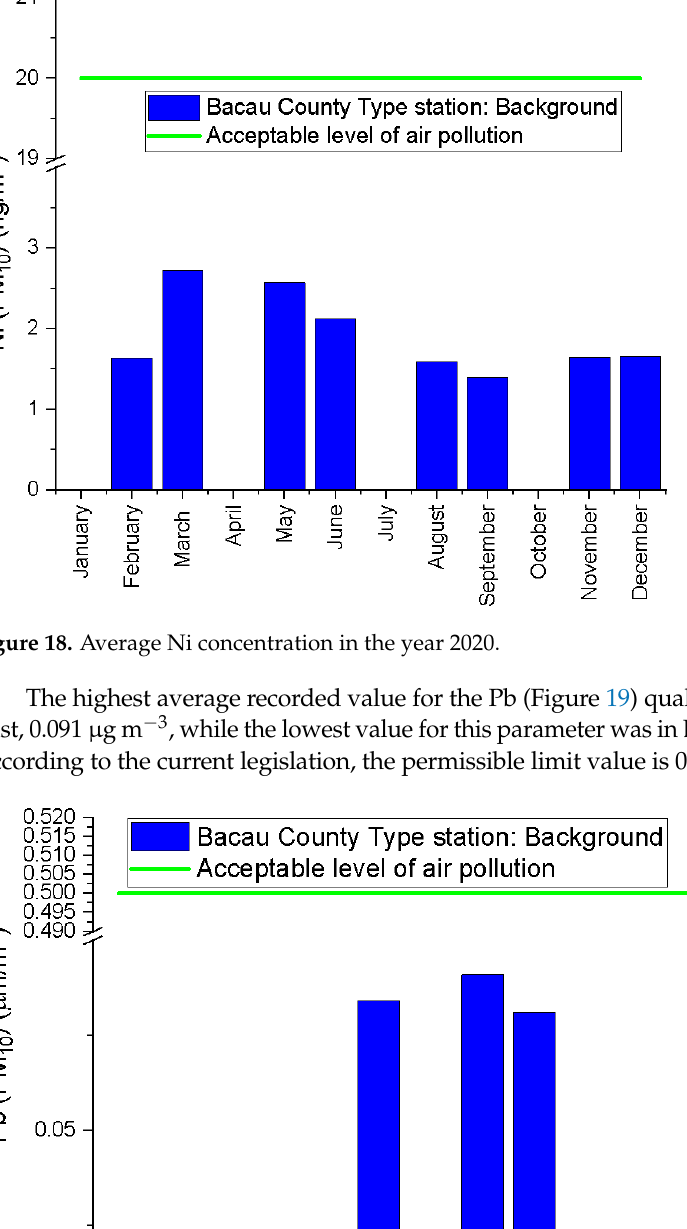
Figure 17. Average As concentration in the year 2020. The measurements for Ni (Figure 18) made in the urban background station did not show any exceedance of the maximum allowable value of 20 ng m − 3 . Thus, the lowest average value was recorded in September, 1.4 ng m − 3 , and the highest average value was recorded in March—2.72 ng m − 3 .